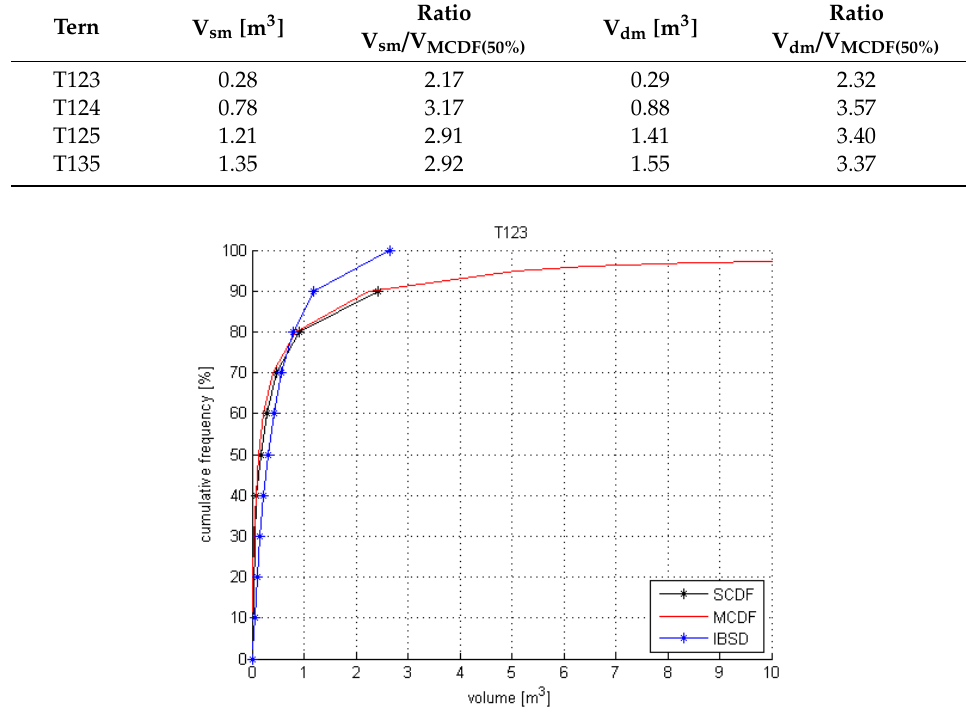
Figure 11. Comparison of block volume distributions obtained for term T123.